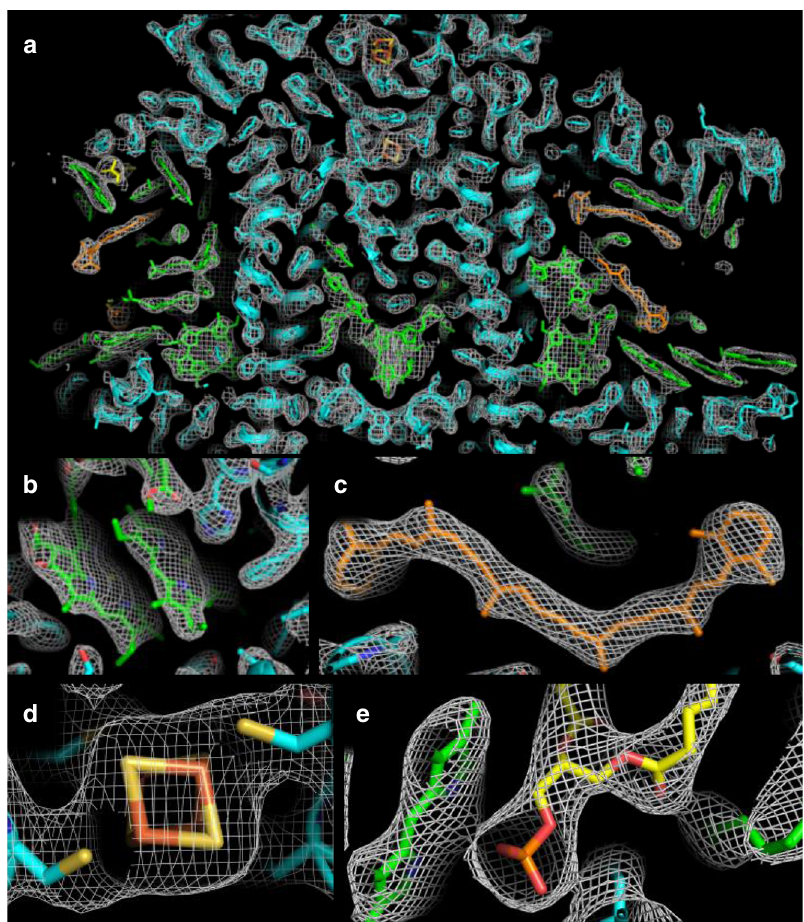
Fig. 3 Electron density map (2Fo – Fc at 1.5 σ ) and model of various PSI structural elements of the XFEL structure of PSI. In all images, protein is colored cyan, chlorophyll (Chl) molecules are colored green, β -carotenes are colored orange, and lipids are colored yellow. In panels b – e , nitrogen atoms are colored blue, oxygen atoms are colored red, and magnesium atoms are colored bright green. a A slice through the center of electron density of a monomer of PSI is shown, b the electron density of the “ special pair ” of Chls, P 700 , c a β -carotene molecule, d the 4Fe – 4S cluster, F X , and e the phosphatidylglycerol